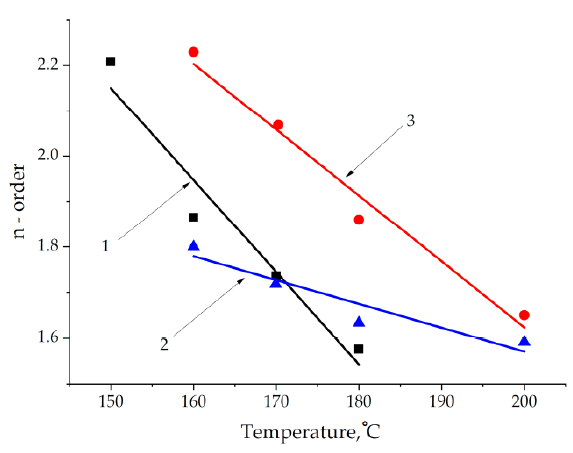
Figure 7. The reaction order-dependencies (n-order) on temperature for formulations